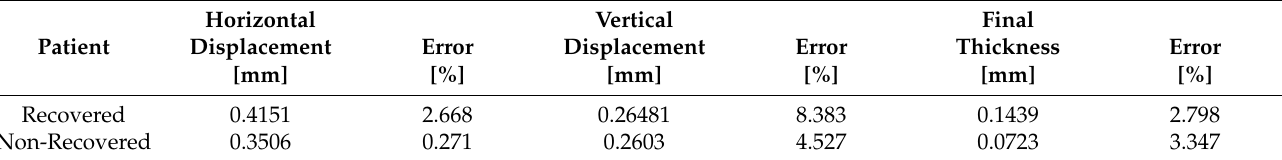
Figure 9. Maximum displacements for the Retina and ERM model, [mm]. Table 4. Results for the retina displacements and membrane